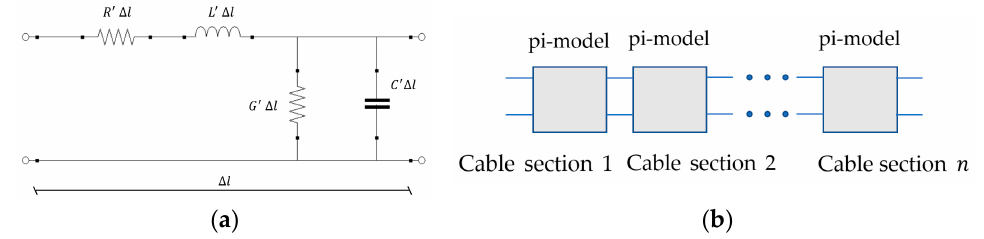
Figure 1. Equivalent model: ( a ) Equivalent lumped circuit of cable sections with length ∆ l ; ( b ) Equivalent lumped circuit of a network branch consisting of several sections.